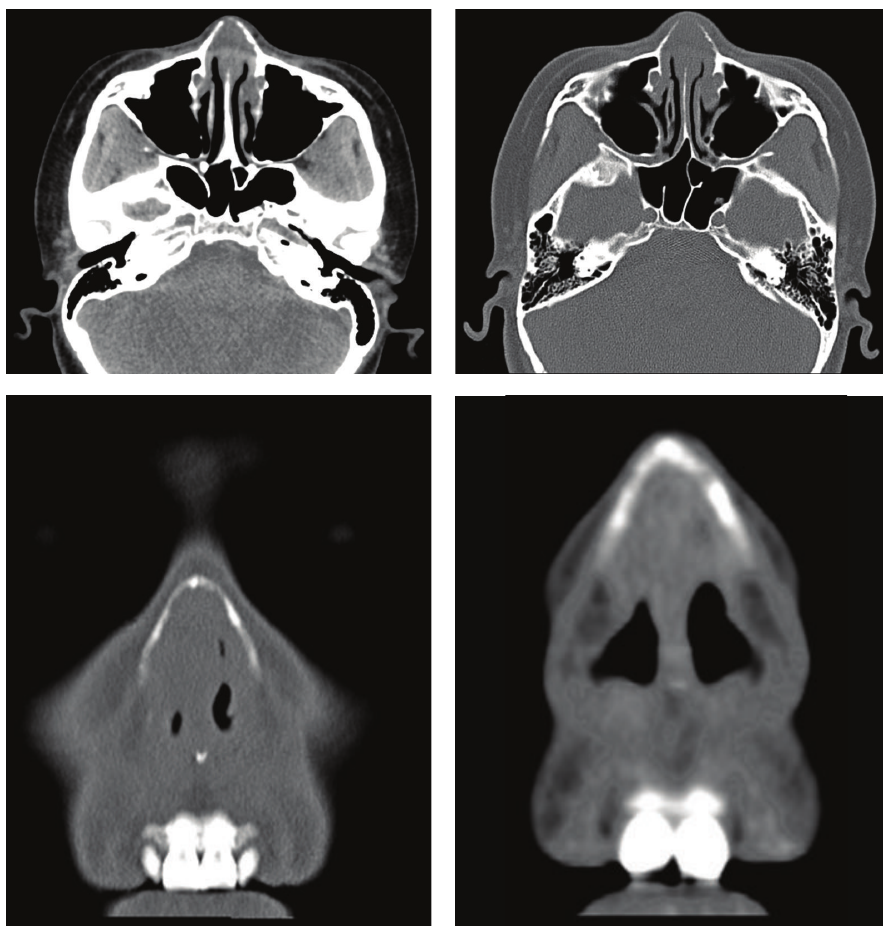
Figure 2: They indicate localized and discontinuous oppressive thinning of the lower edge of frontal process of maxilla.